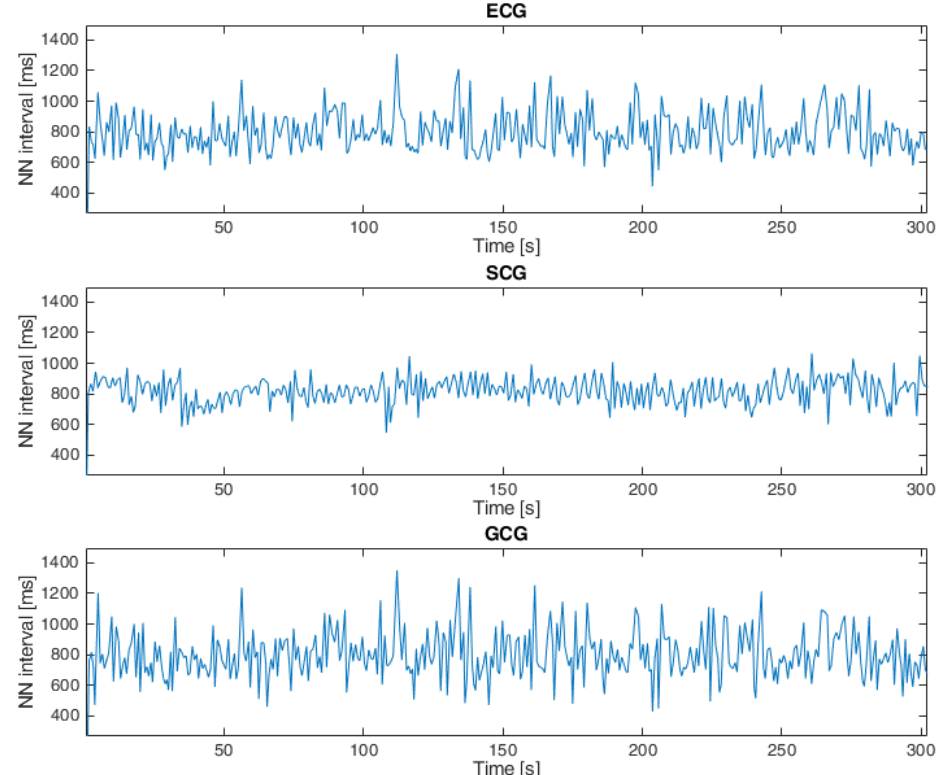
Figure 5. Tachogram ECG, SCG and GCG signals taken from subject UP-09 in the second